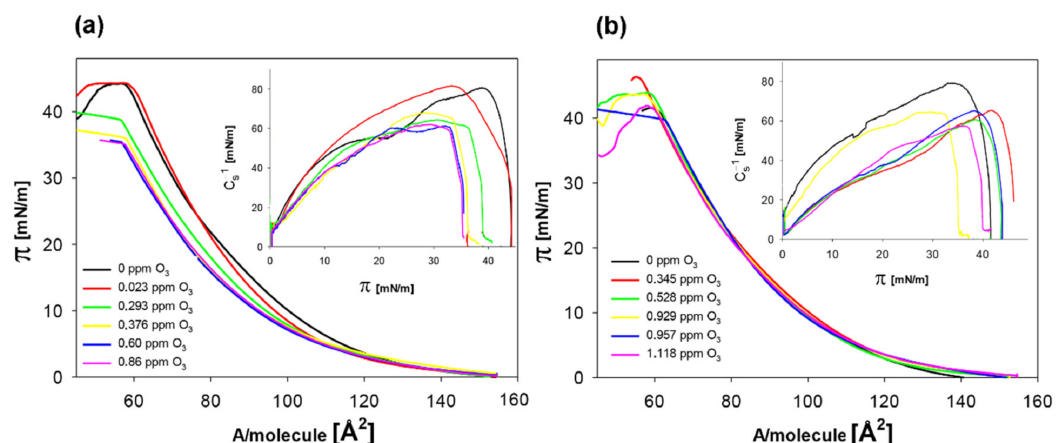
Figure 4. Surface pressure isotherms and corresponding compressibility modulus (inset) of lipid model of neuroblastoma layers spread on the subphase contained the indicated concentrations of ozone dissolved in buffer. Isoterms: ( a ) in the absence of antioxidants; ( b ) in the presence of quercetin (6.25 µ M) added to the ozone-containing buffer.